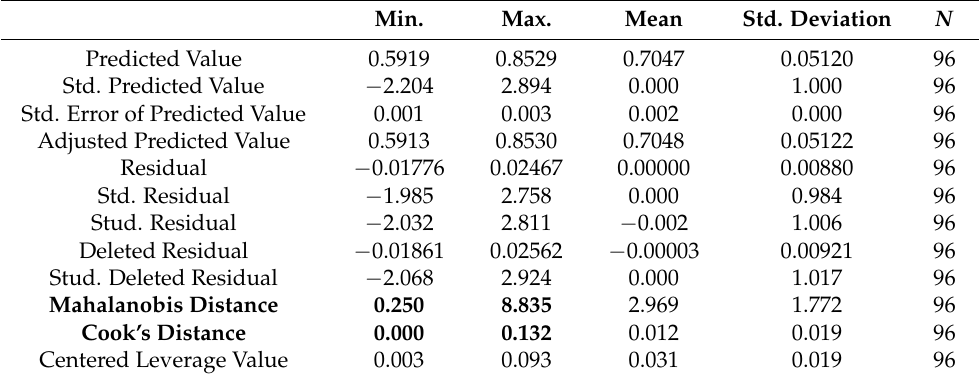
Centered Leverage Value